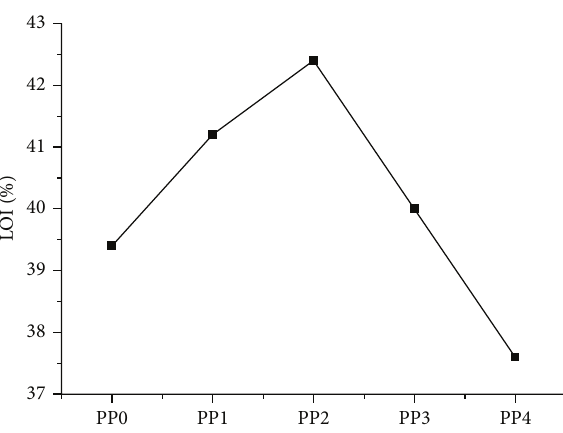
Figure 6: The LOI curve of flame retardant PP